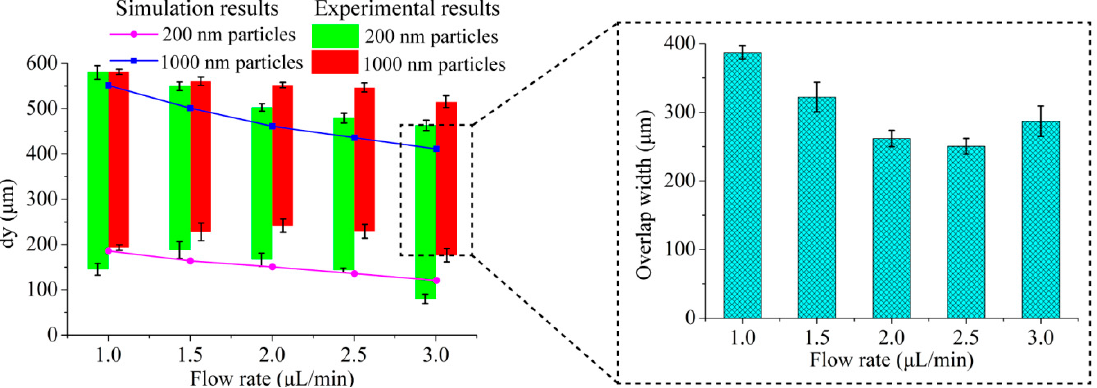
Figure 5. Comparison between simulation results and experimental results on particle distribution along y -axis at the outlet area under different flow rates of the sample flow.